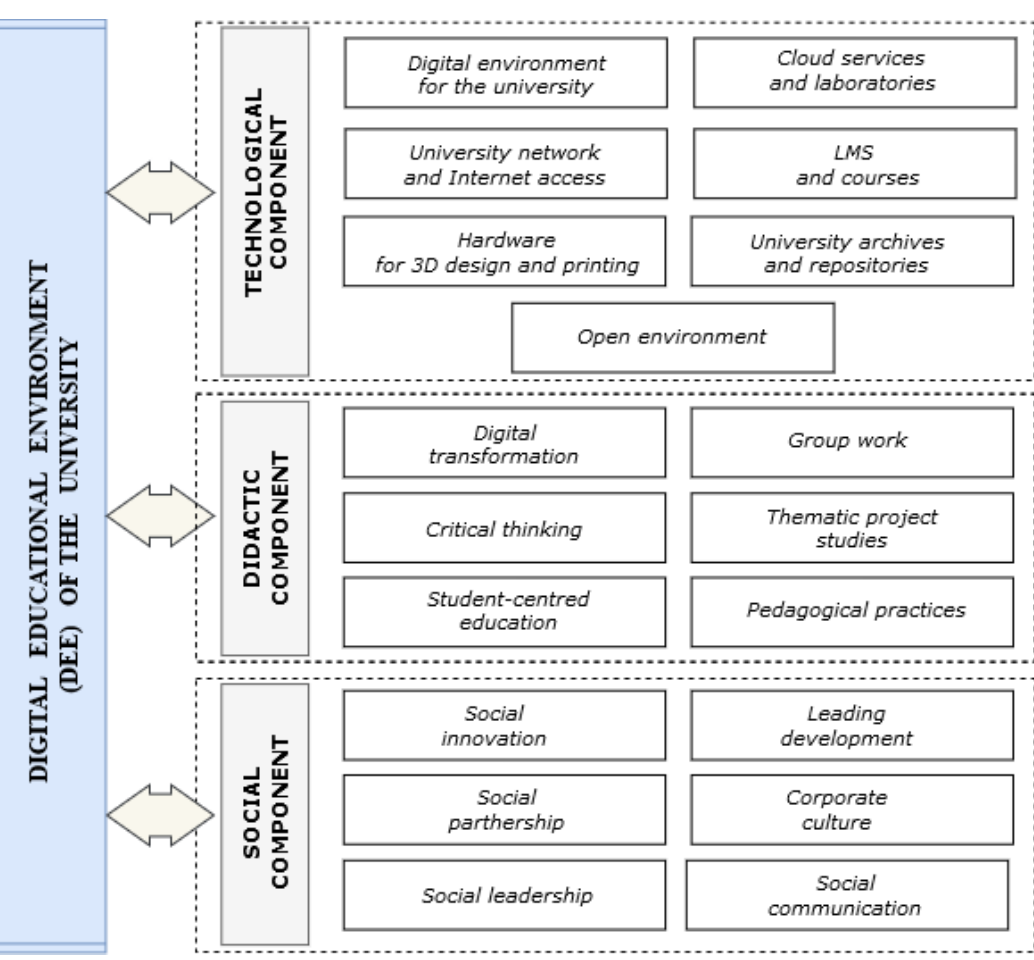
Figure 73: Presentation of paper